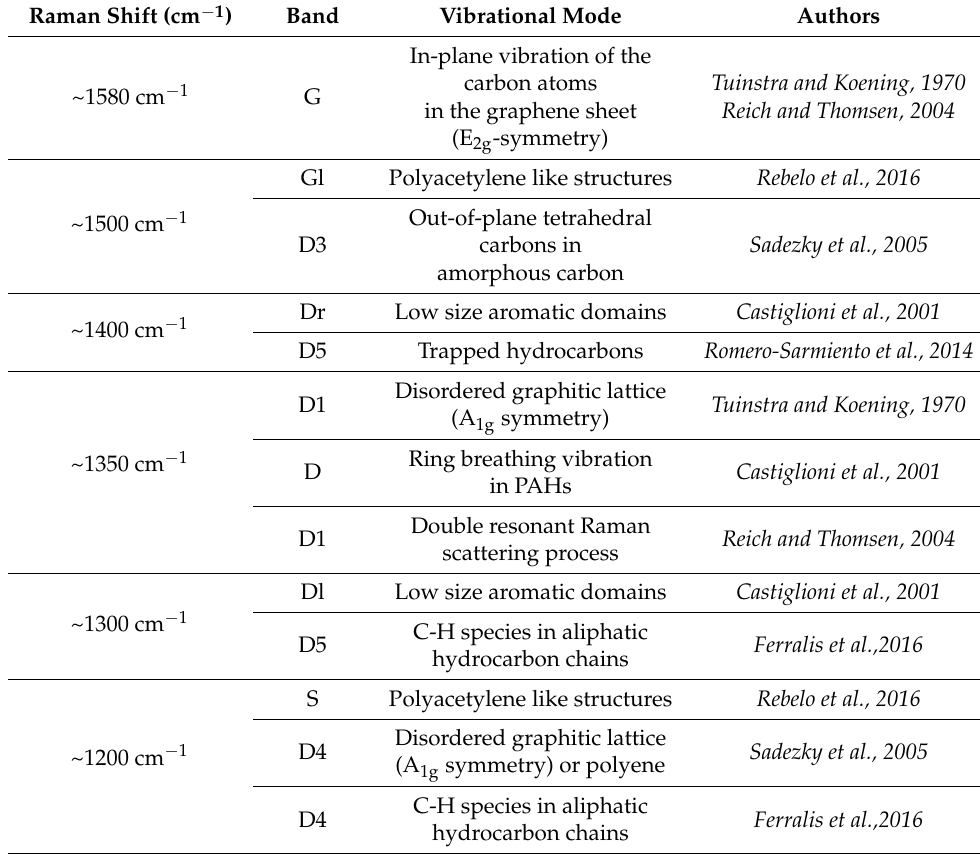
Table 1. First-order Raman bands and vibration modes reported by different authors. Raman shift are approximated and bands name can change according to different authors